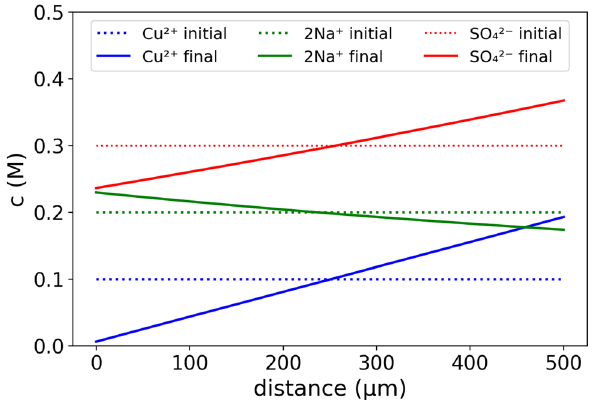
Figure 3. Modeled concentration gradients (using the parameterization case iv as defined in the text below) at the limited current for an electrode distance of 500 µm, a CuSO 4 concentration of 0.1 M, and a Na 2 SO 4 concentration of 0.2 M. The cathode is located at the left side (distance = 0) and the anode at the right side (distance = 500